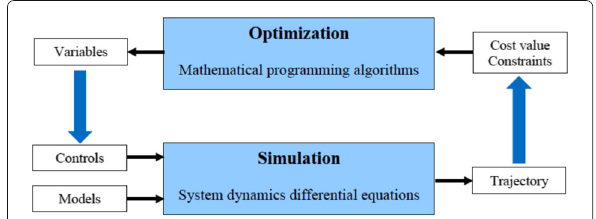
Fig. 5 Simulation and optimization